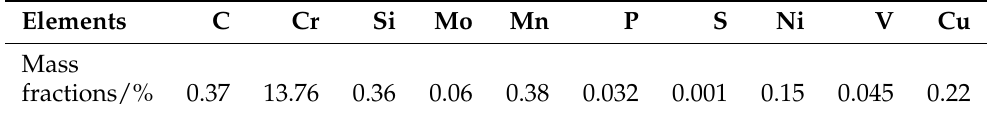
Table 1. Chemical composition of the investigated steel X30Cr13 by spectrometric analysis (bal- ance